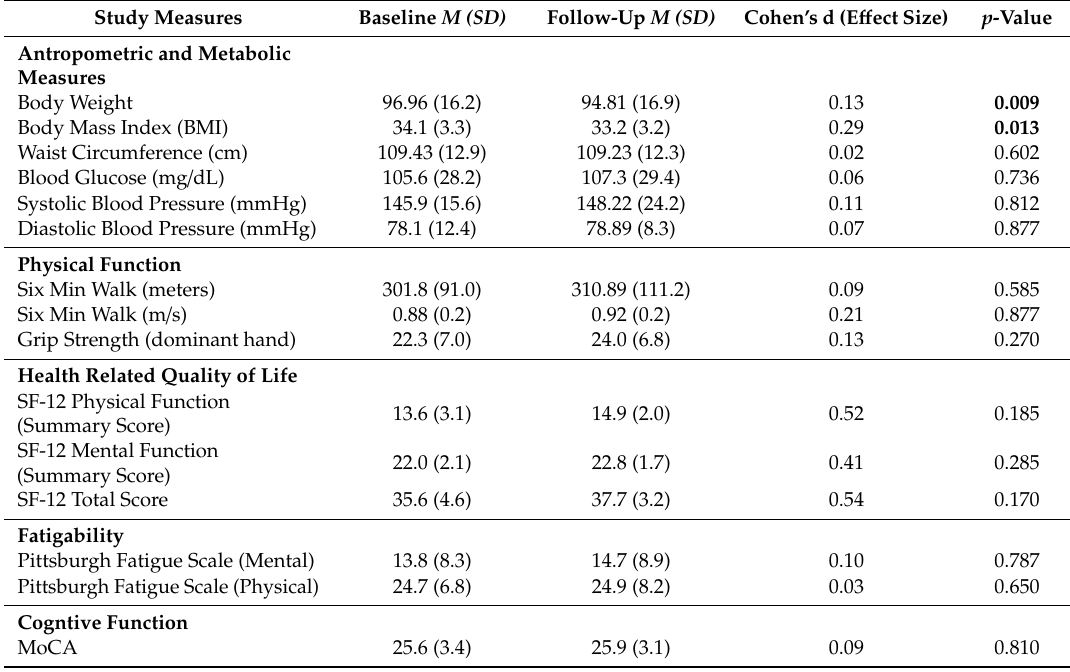
Table 1. Baseline and Follow-Up Values on All Study